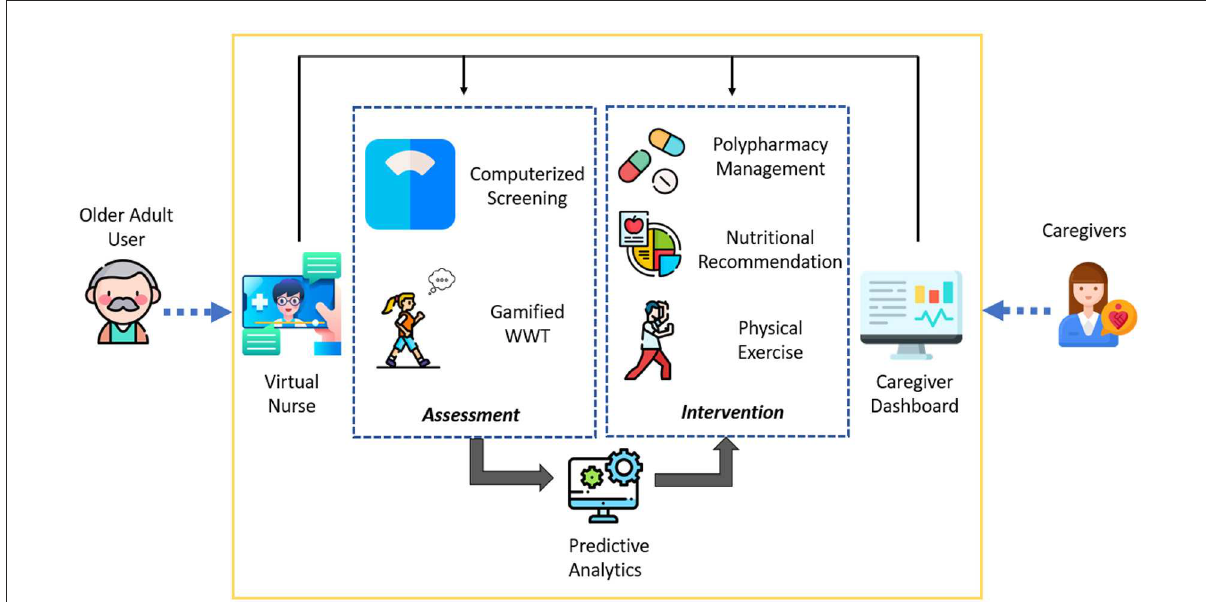
FIGURE1 Conceptual diagram of system for assessment and intervention of frailty (SAIF) depicting the integrated elements of interface, assessment, and intervention components.